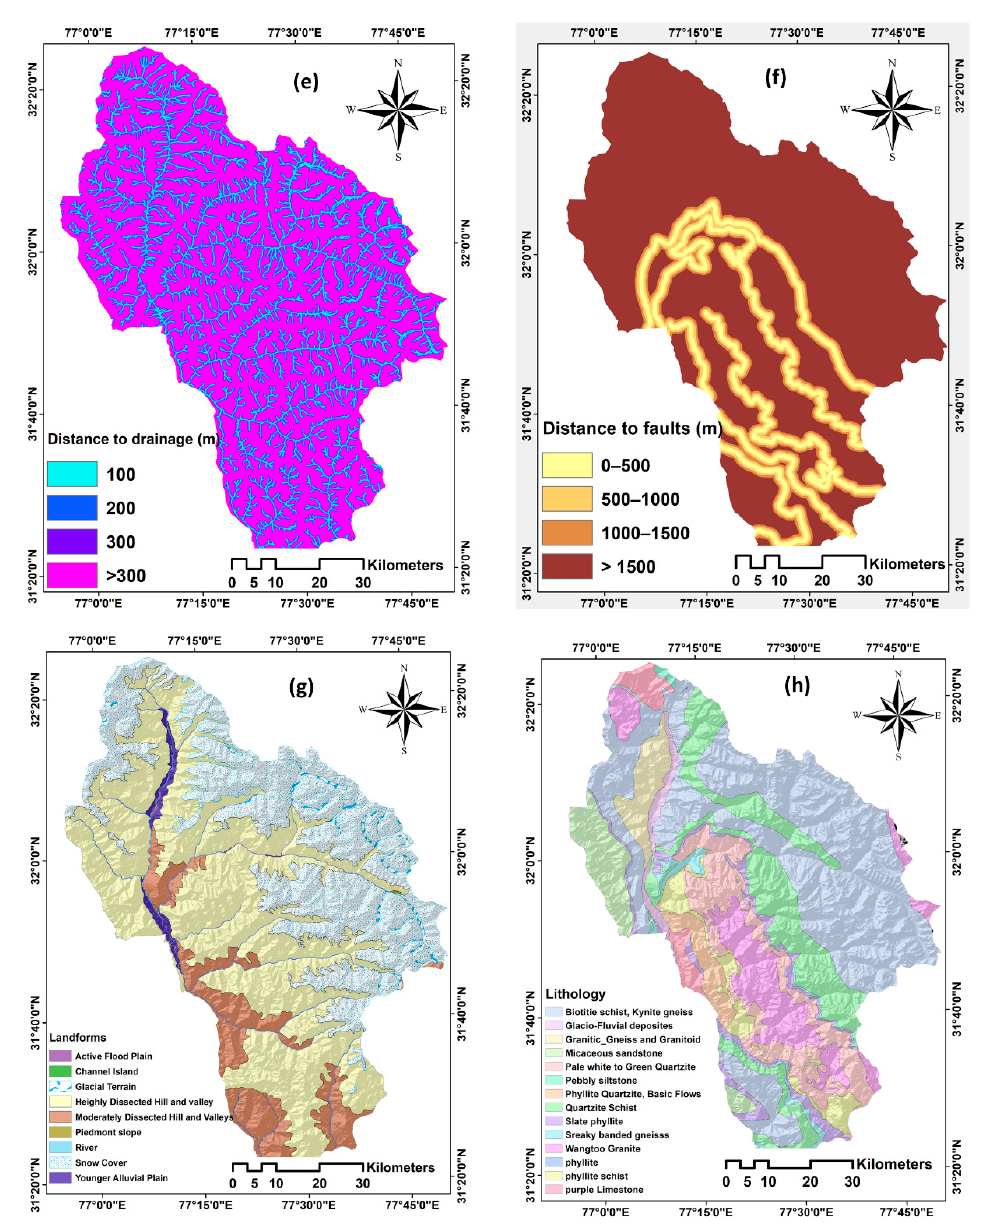
Figure 3. The conditioning factors used in this study are as follows: ( a ) Elevation, ( b ) slope angle, ( c ) slope aspect, ( d ) distance to roads, ( e ) distance to drainage, ( f ) distance to faults, ( g ) landforms, ( h ) lithology.